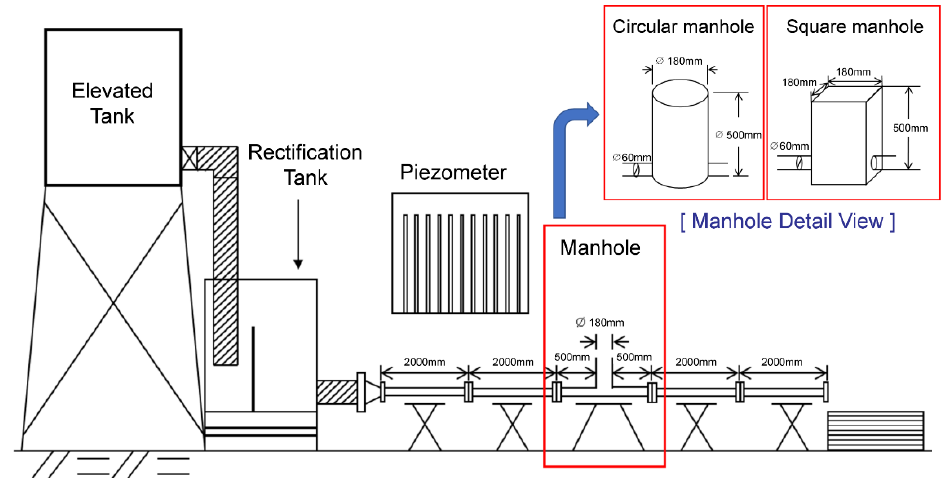
Figure 2. Experimental apparatus for the estimation of head loss coefficients.